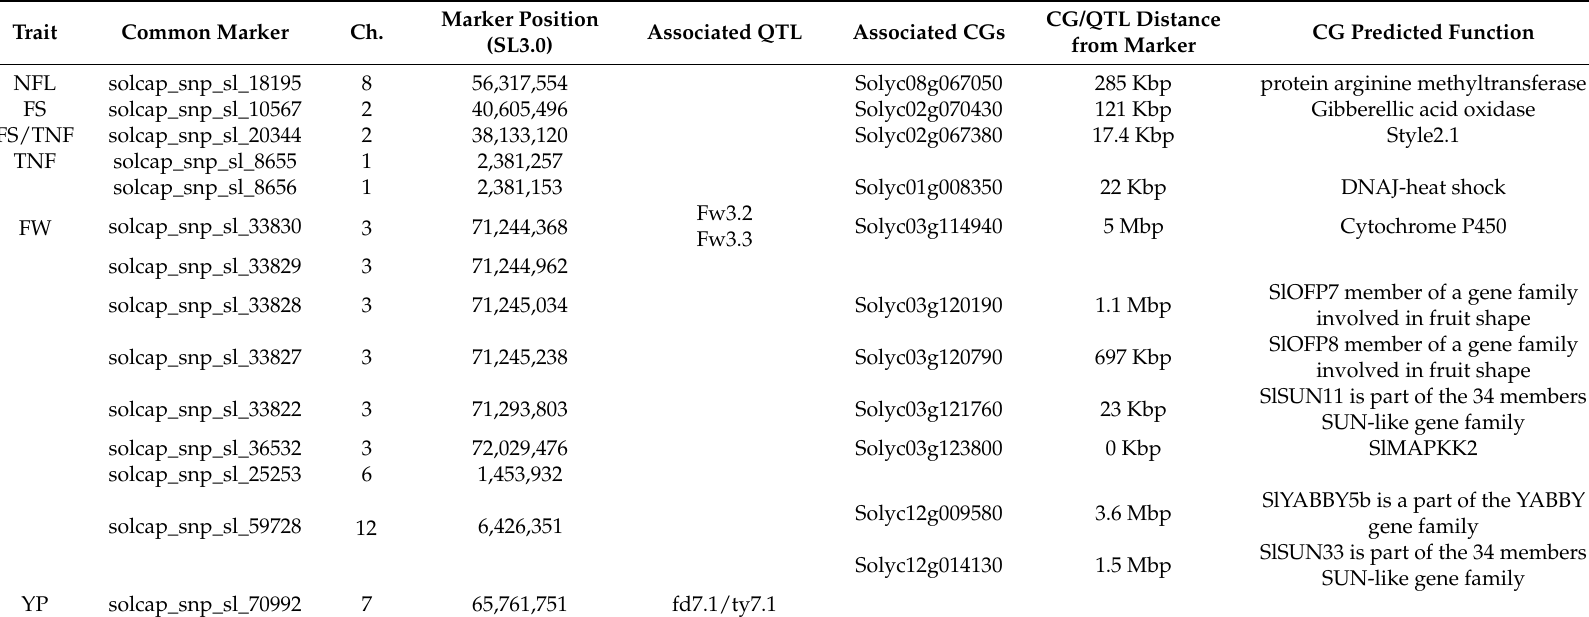
Table 3. Co-localization of common associated markers and candidate genes. For each marker, the SolCap ID, the Chromosome (Ch), the position on SL3.0 tomato genome assembly, the co-localized known quantitative trait loci (QTLs), the co-localized candidate genes (Associated CGs) and the corresponding distance from the associated marker as well as the functional description (CG predicted function) of each CG are